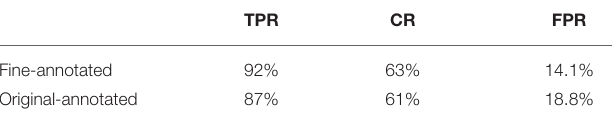
TABLE 4 | ResNeXt-50 on fine-tuned annotated video.